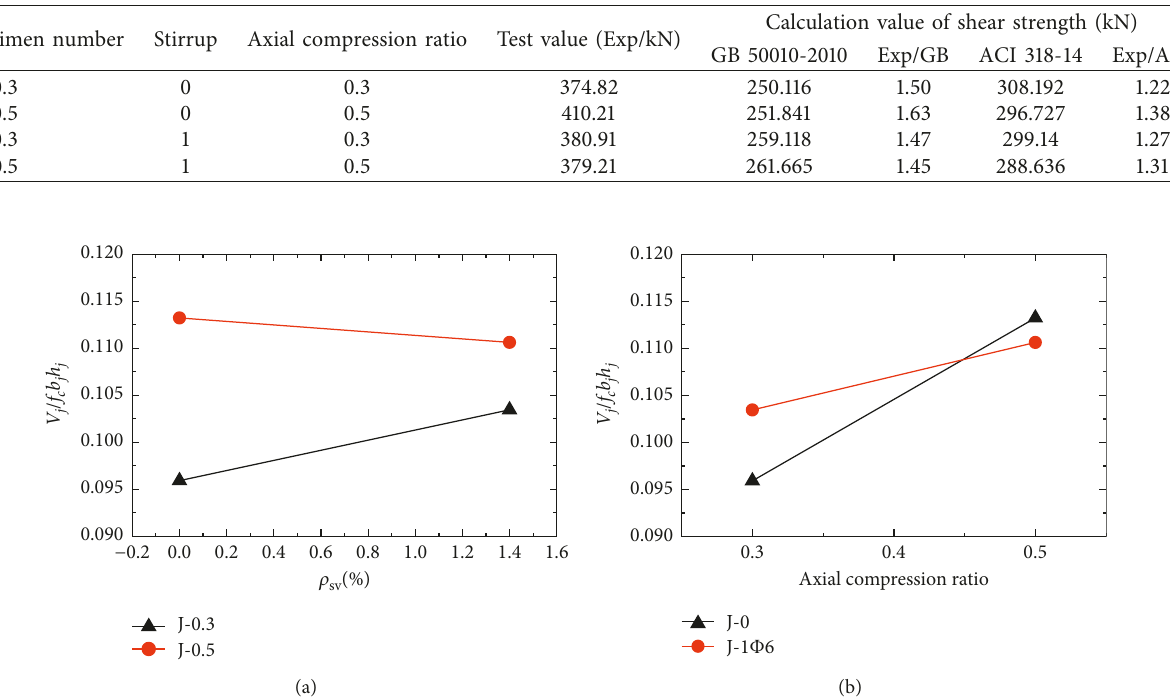
Figure 12: Influence of axial compression ratio and stirrup ratio to shear-compression ratio. (a) Stirrup ratio of joint core. (b) Axial compression